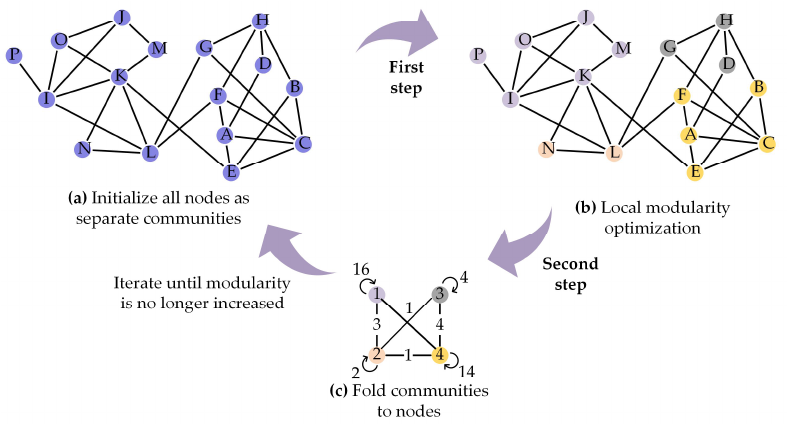
Figure 3. The process of the Louvain algorithm. ( a ) is the initial setup of the network, assigning all nodes as separate communities, ( b ) is the result of local modularity optimization, where different colors mean different communities, and ( c ) is the result of folding communities into new nodes, forming a new network, where the new network contains edges not only between nodes but also within nodes.